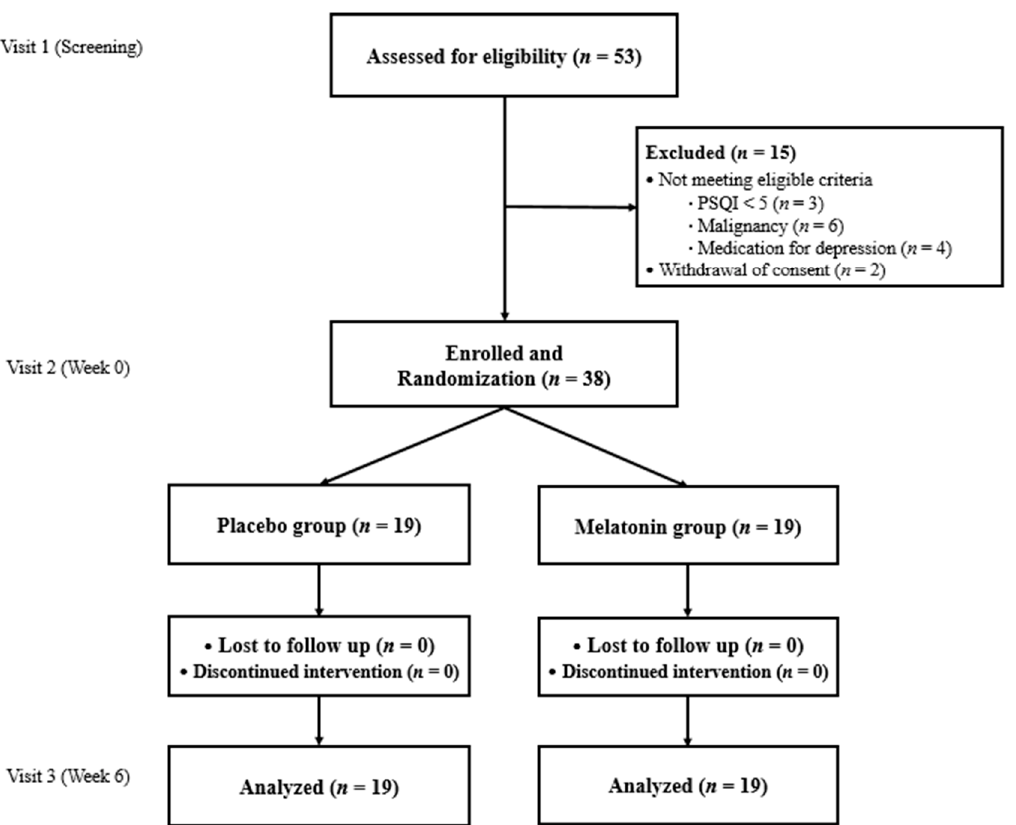
Figure 1. Flow diagram representing the study selection.